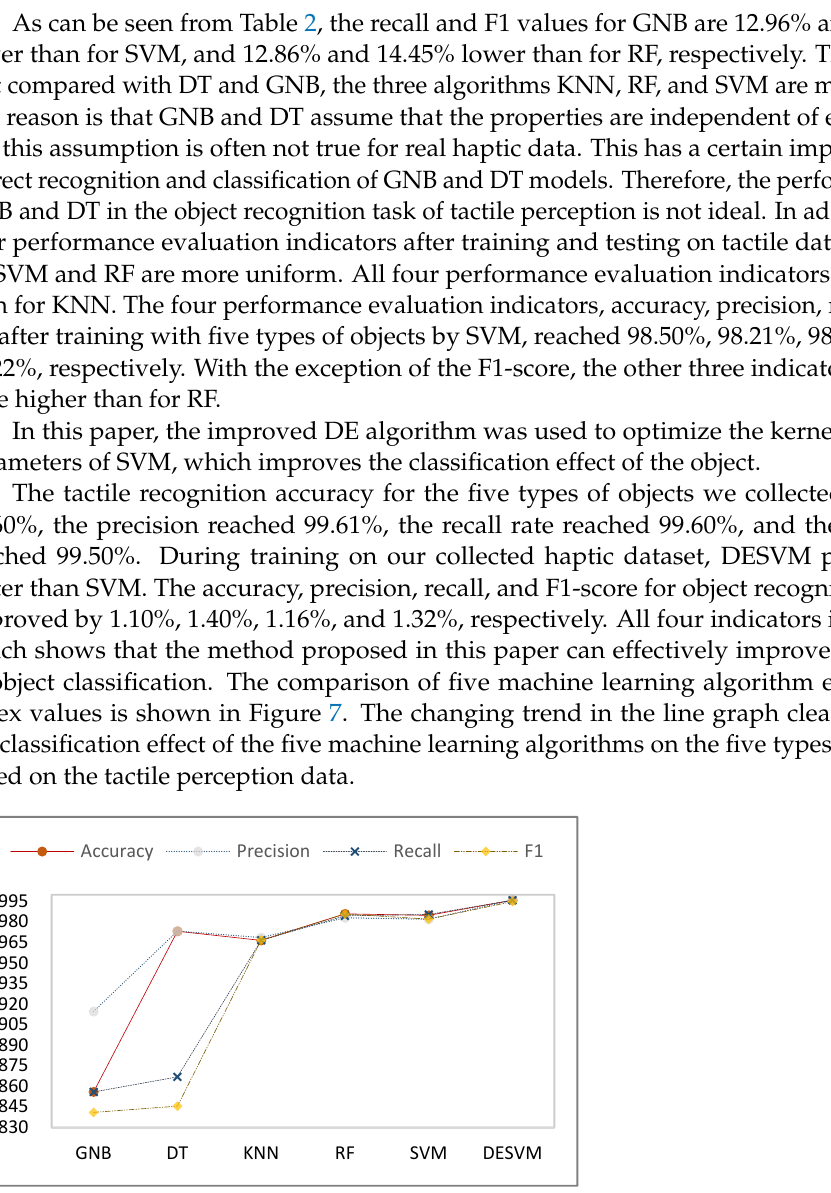
Table 3. The average (Avg) and standard deviation (Std) of the accuracy for ten-fold cross-valida- tion.